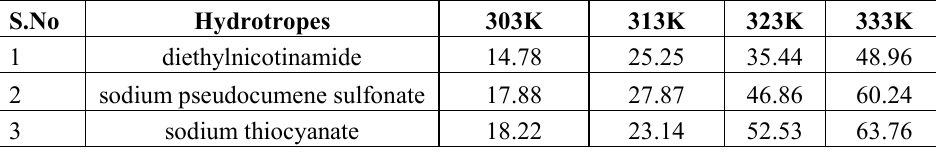
Table 2. Effectiveness of hydrotrop